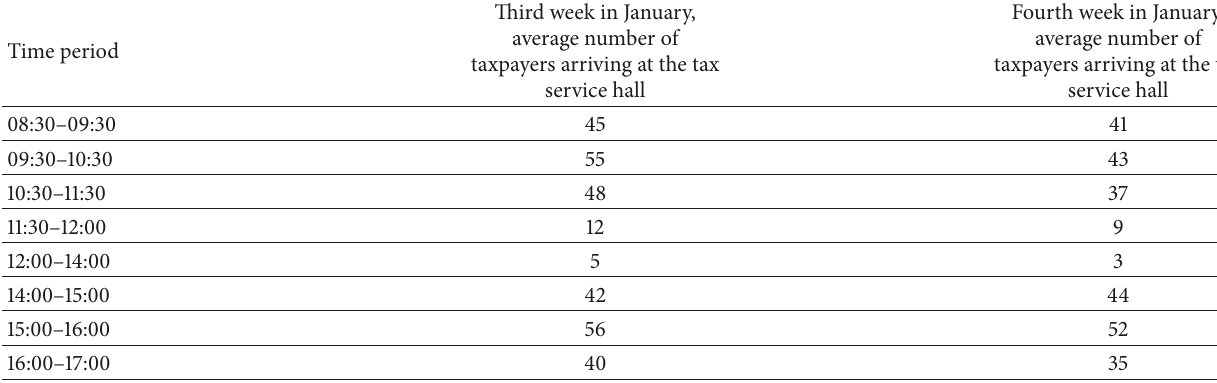
Table 1: Number of taxpayers arriving at the tax service hall per time period.